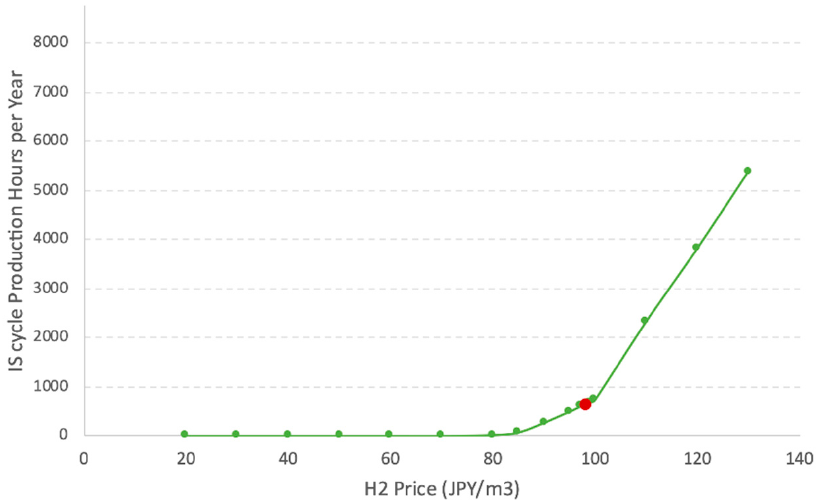
Figure 10 . Utilization rate of the IS unit plotted against the hydrogen price. As the hydrogen price rises, hydrogen deployment becomes increasingly more economically advantageous than electricity sale, so the number of hydrogen production hours increases. The red dot represents the breakeven LCOH.